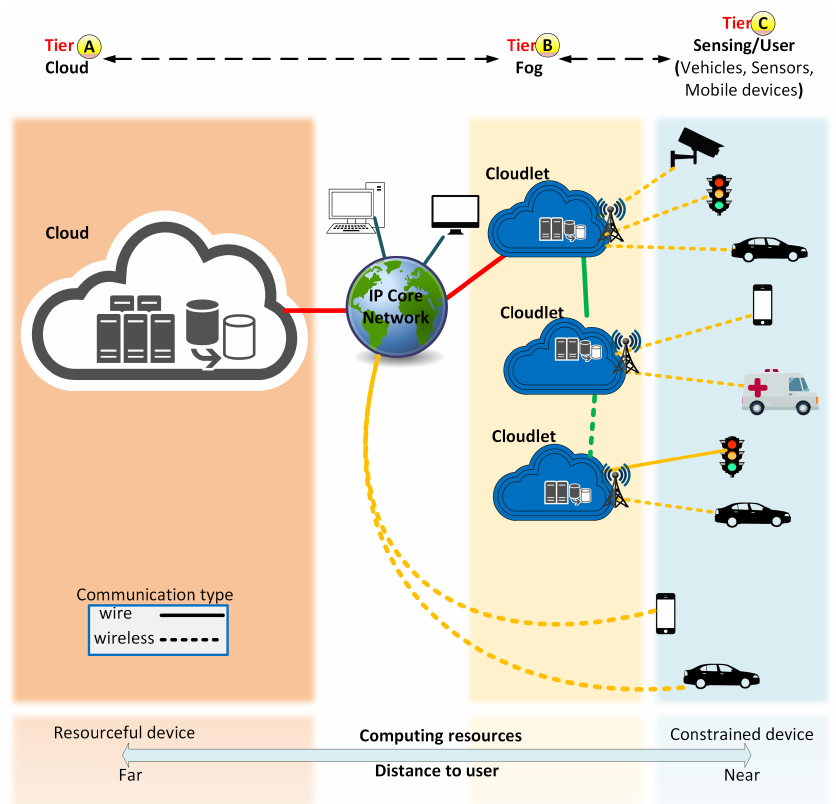
Figure 1. Cloud and Fog